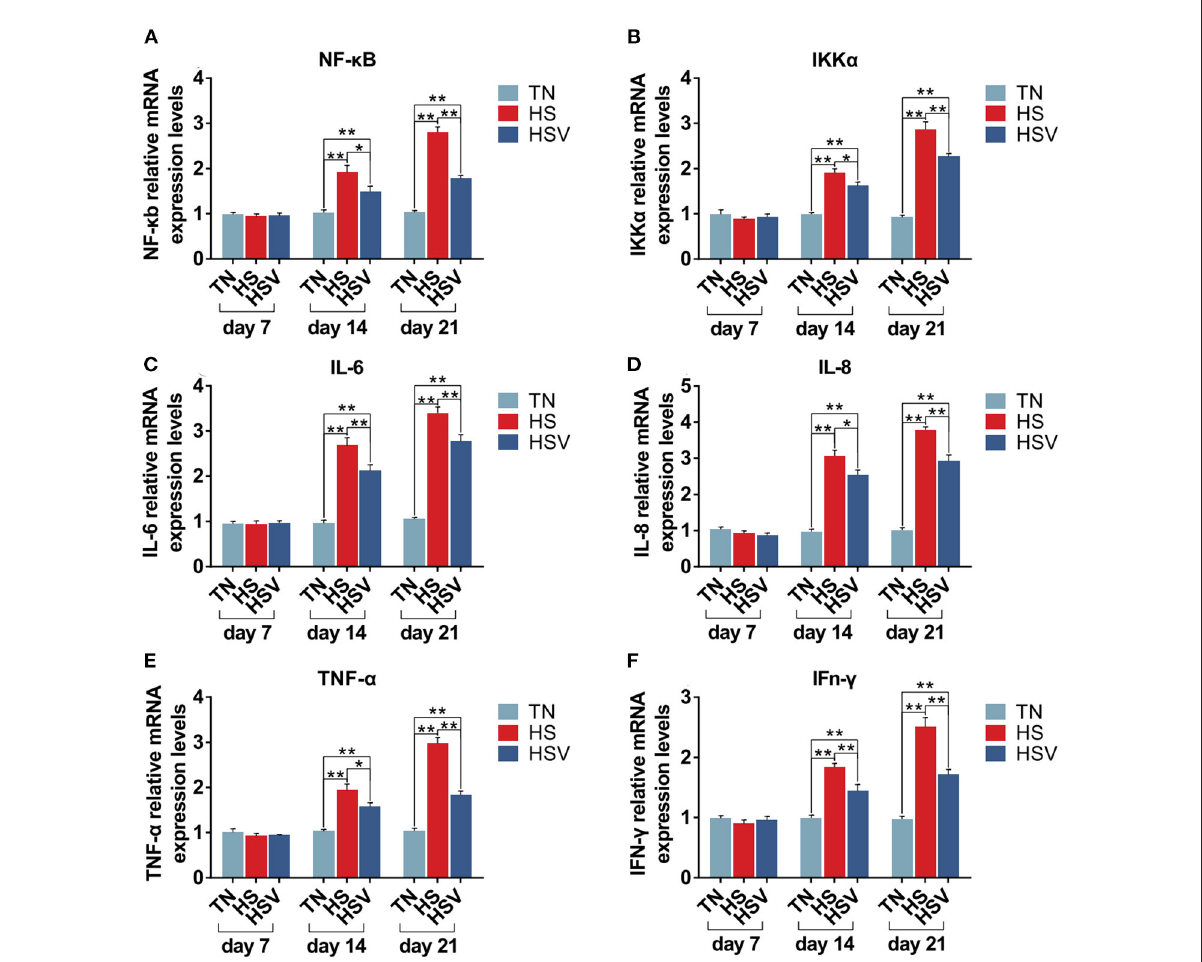
FIGURE5 Effects of vitamin C on chronic heat stress-induced changes in the mRNA expression of inflammatory genes in the liver. (A) mRNA expression of NF- κ B; (B) mRNA expression of IKK- α ; (C) mRNA expression of IL-6; (D) mRNA expression of IL-8; (E) mRNA expression of TNF- α ; and (F) mRNA expression of IFn- γ